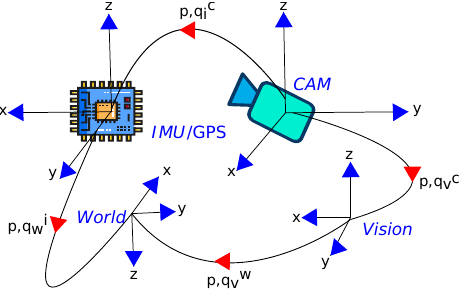
Figure 5. The frames of reference